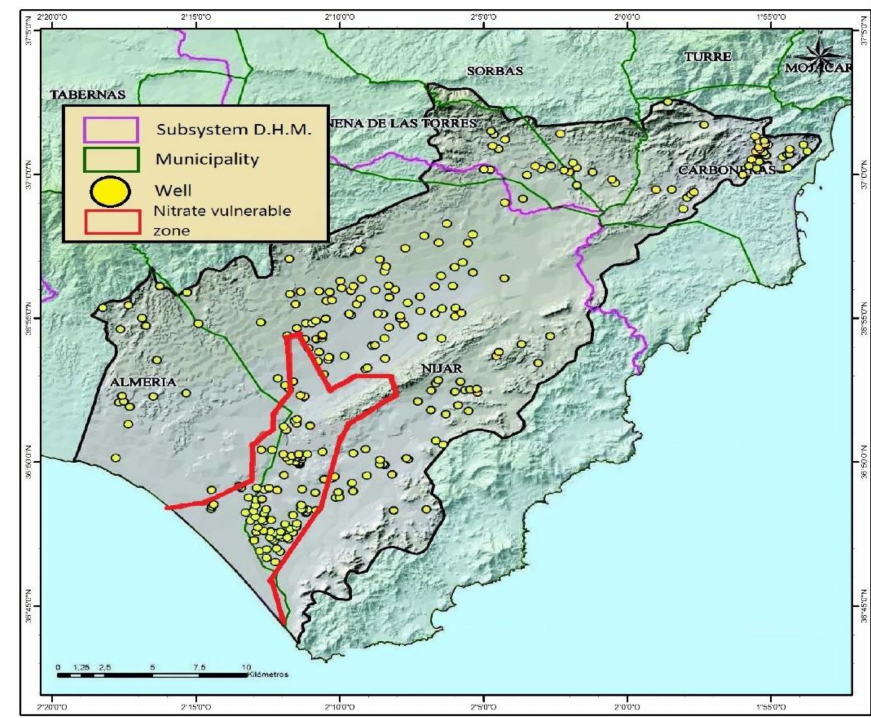
Figure 2. Extraction wells of the Campo de N í jar aquifer *. * Adapted from the Hydrological Plan for the Andalusia Mediterranean Basin (Plan Hidrol ó gico de la Demarcaci ó n Hidrogr á fica de las Cuencas Mediterr á neas